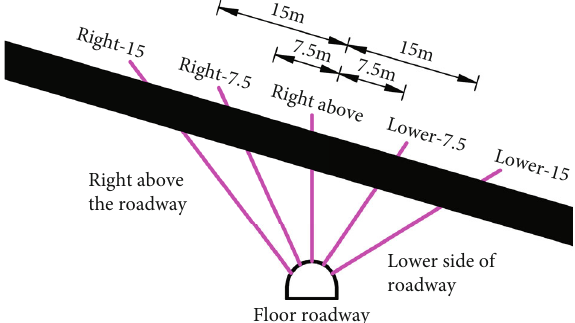
Figure 13: Drill hole layout plan.